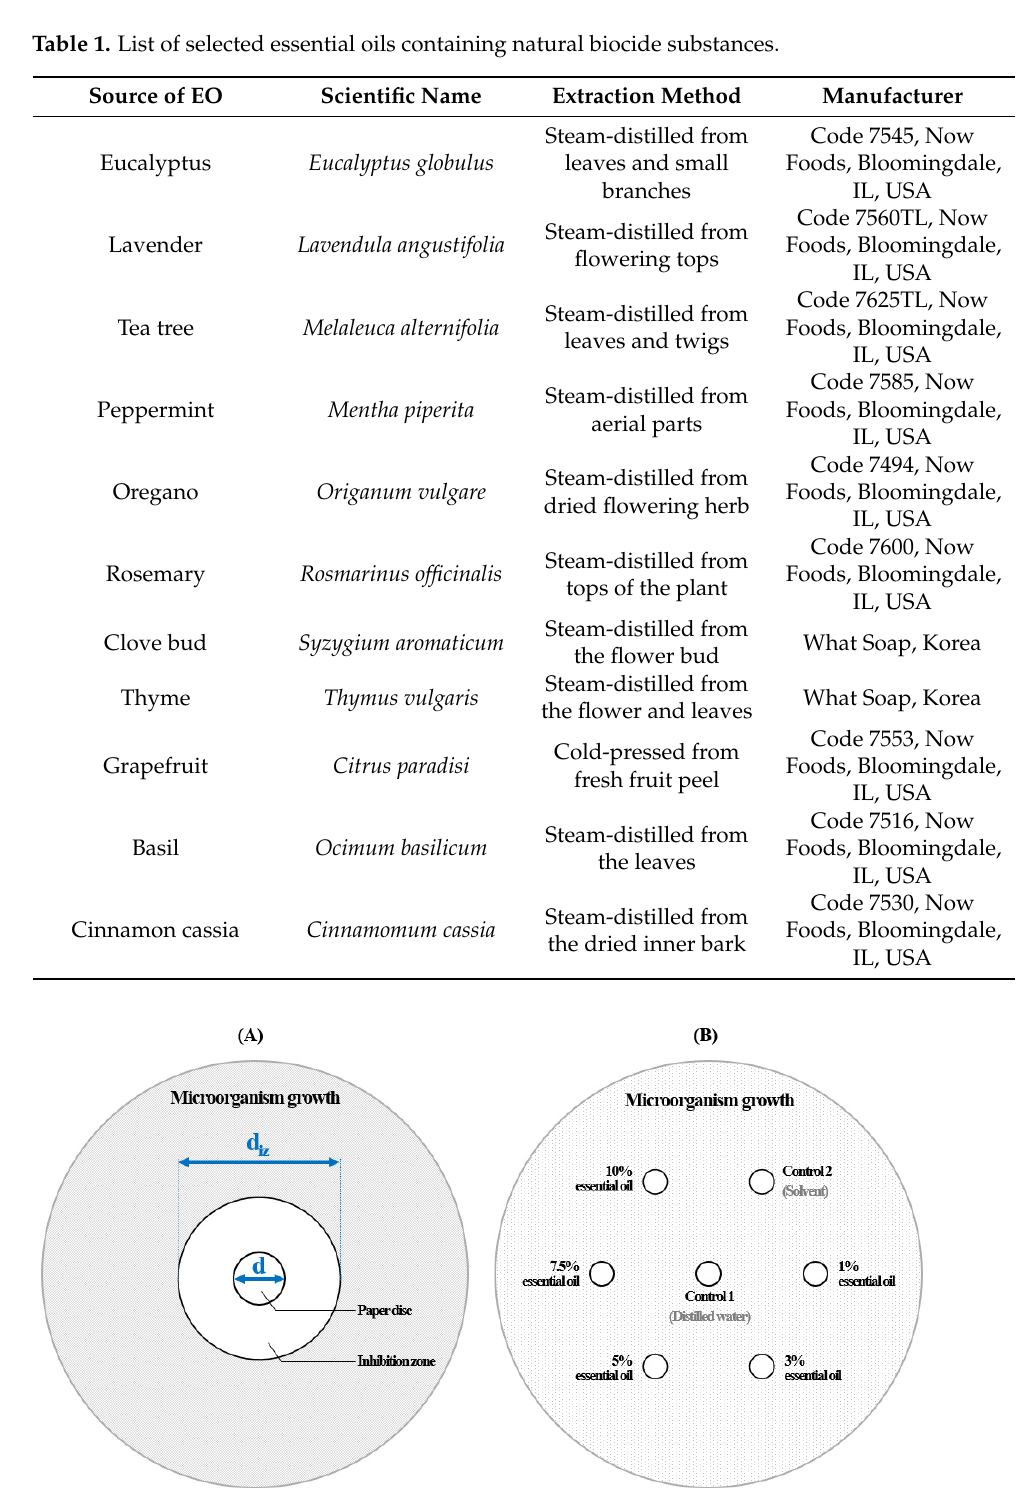
Figure 2. Evaluation of antifungal and antibacterial activities. ( A ) Measurements for the normalized width of the inhibition zone. ( B ) Location of the paper disc to test the antifungal and antibacterial activities of low-concentration essential oils.